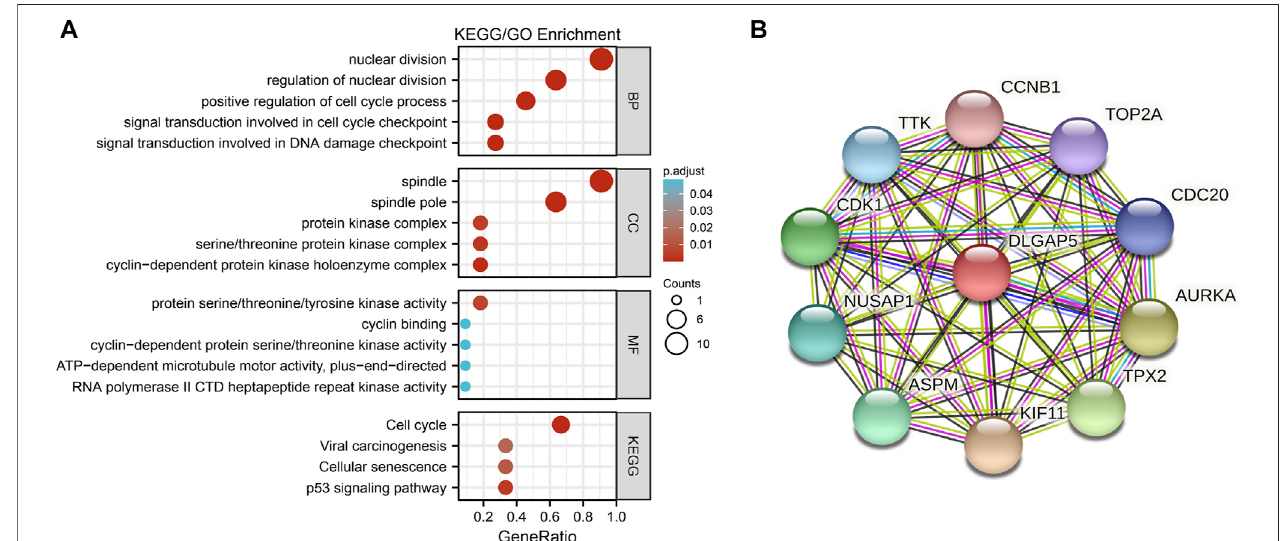
FIGURE3| TheGO/KEGGenrichmentanalysisandPPInetwork. (A) AbubbleplotwasusedtoshowtheresultsoftheGO/KEGGenrichment.Thecolorofbubble was on behalf of the adjusted value (p.adjust) and the size of bubble represent the degree of enrichment. (B) The PPI network was used to show DLGAP5 and its correlated genes including CCNB 1, TOP2A, CDC20, AURKA, TPX2, KIF11, ASPM, NUSAP1, CDK1, and TTK.